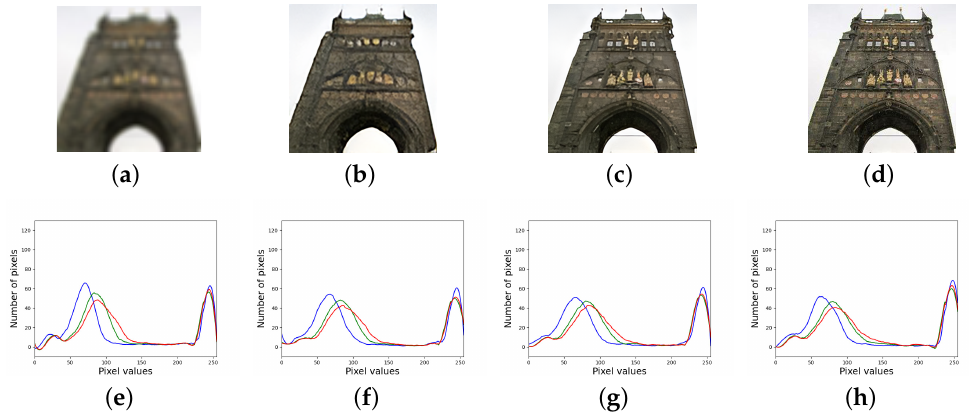
Figure 9. Comparison results on LSUN with their corresponding pixel histograms. ( a ) Blur image; ( b ) Without L 1; ( c ) With L 1; ( d ) Sharp image; ( e ) Histogram of ( a ); ( f ) Histogram of ( b ); ( g ) Histogram of ( c ); ( h ) Histogram of ( d